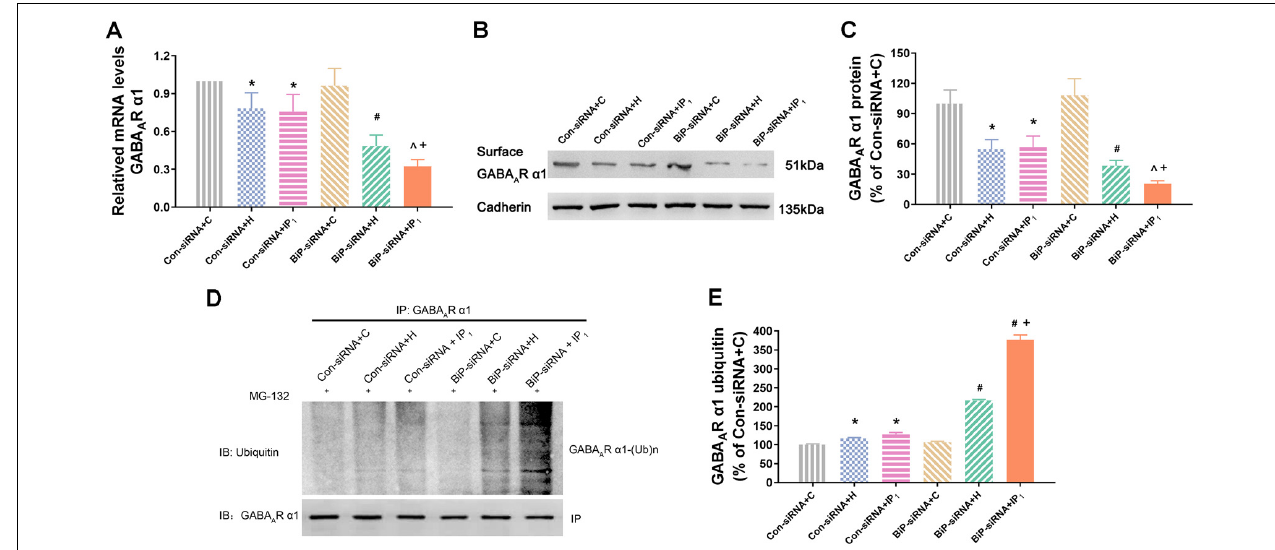
FIGURE 4 | Knockdown of BiP by siRNA aggravated the disturbance of GABA A R α 1 subunit protein homeostasis caused by anesthetics. (A) mRNA level analysis of GABA A R α 1 subunit in neurons. Note that 1% isoflurane and 1.2 µ g/ml of propofol resulted in a significant decrease of GABA A R α 1 subunit transcription in neurons after treatment with BiP siRNA. (B,C) The expression of GABA A R α 1 subunit in hippocampal neurons was determined by Western blotting. Note that 1% isoflurane and 1.2 µ g/ml of propofol resulted in a significant decrease of GABA A R α 1 subunit expression in neurons after treatment with BiP siRNA. (D,E) Ubiquitin GABA A R α 1 of expression level increased in hippocampal neurons was determined by immunoprecipitation and Western blotting. Note that 1% isoflurane and 1.2 µ g/ml of propofol resulted in a significant increase of GABA A R α 1 subunit degradation in neurons after treatment with BiP siRNA. Data are expressed as the mean ± SD ( n = 6/group). * P < 0.05 compared with group Con-siRNA + C; # P < 0.05 compared with group Con-siRNA + H; ∧ P < 0.05 compared with group Con-siRNA + IP 1 ; + P < 0.05 compared with group BiP-siRNA +